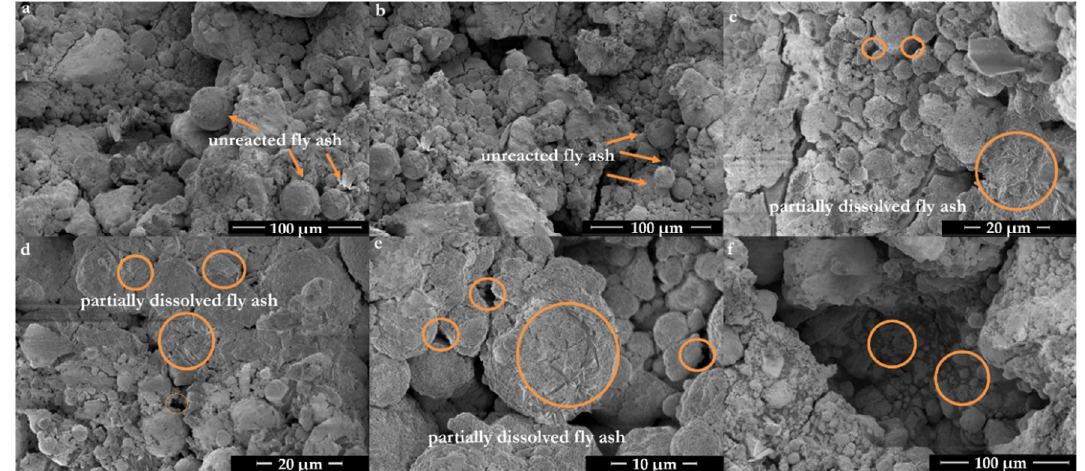
Figure 7. SEM images of SO-CFA sample. ( a ) unreacted fly ash at 750× magnification; ( b ) unreacted fly ash at 700× magnification; ( c , d ) partially dissolved fly ash at 2500× magnification; ( e ) presence of voids and needle-like structures at 5000× magnification; ( f ) partial polymerization at 750× magnification.